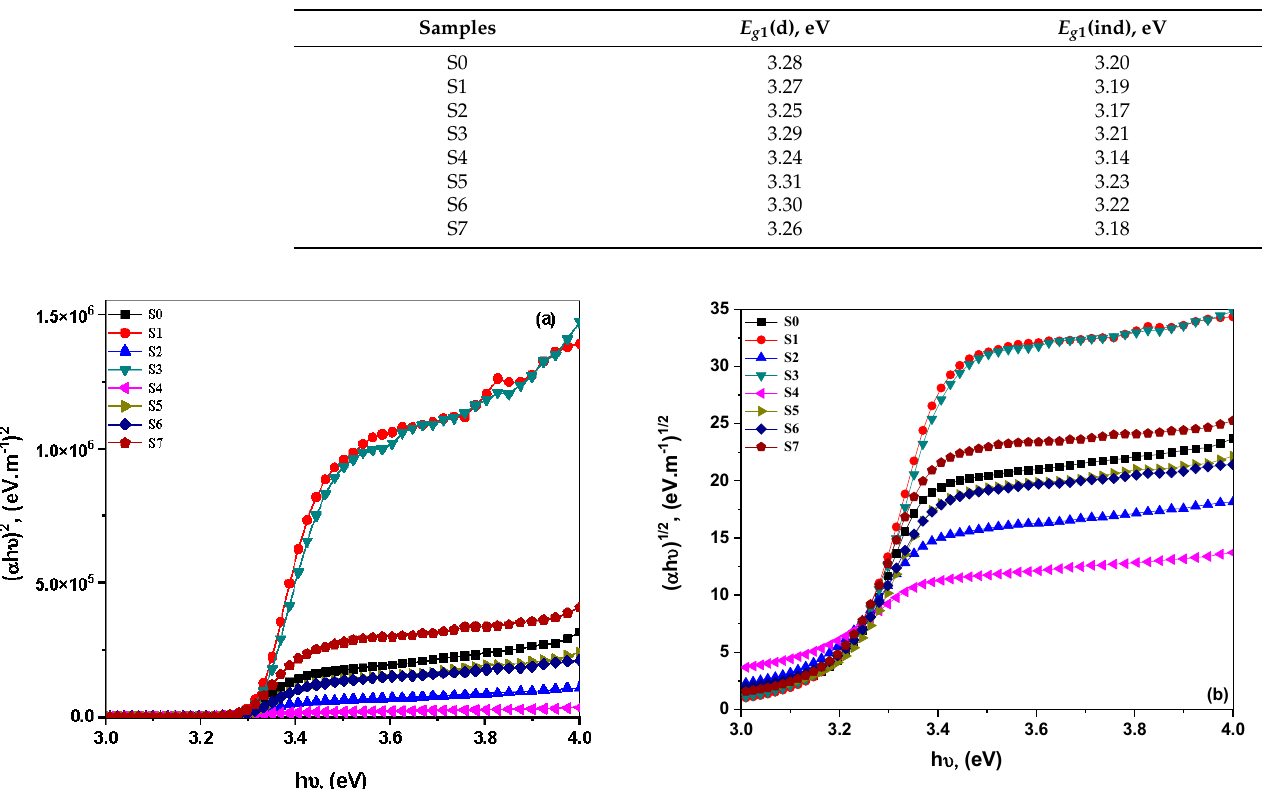
Table 3. The calculated optical energy bandgaps (both direct and indirect transitions) of Eu 2 O 3 -doped ZnO nanoparticles.